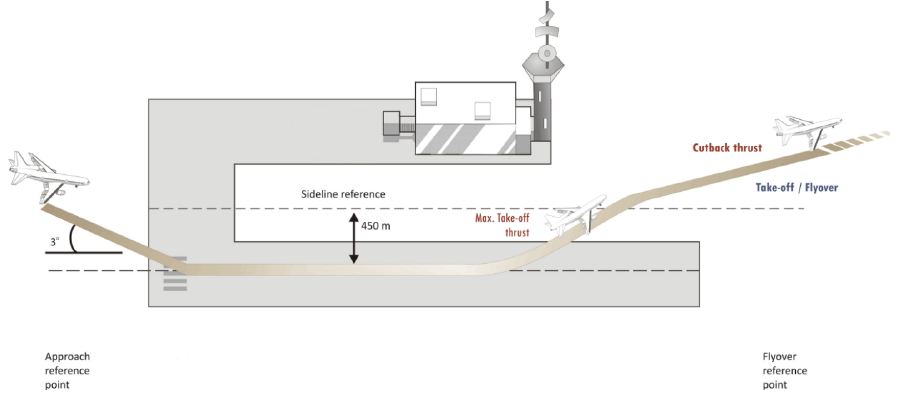
Figure 4. Aircraft noise certification reference measurement points